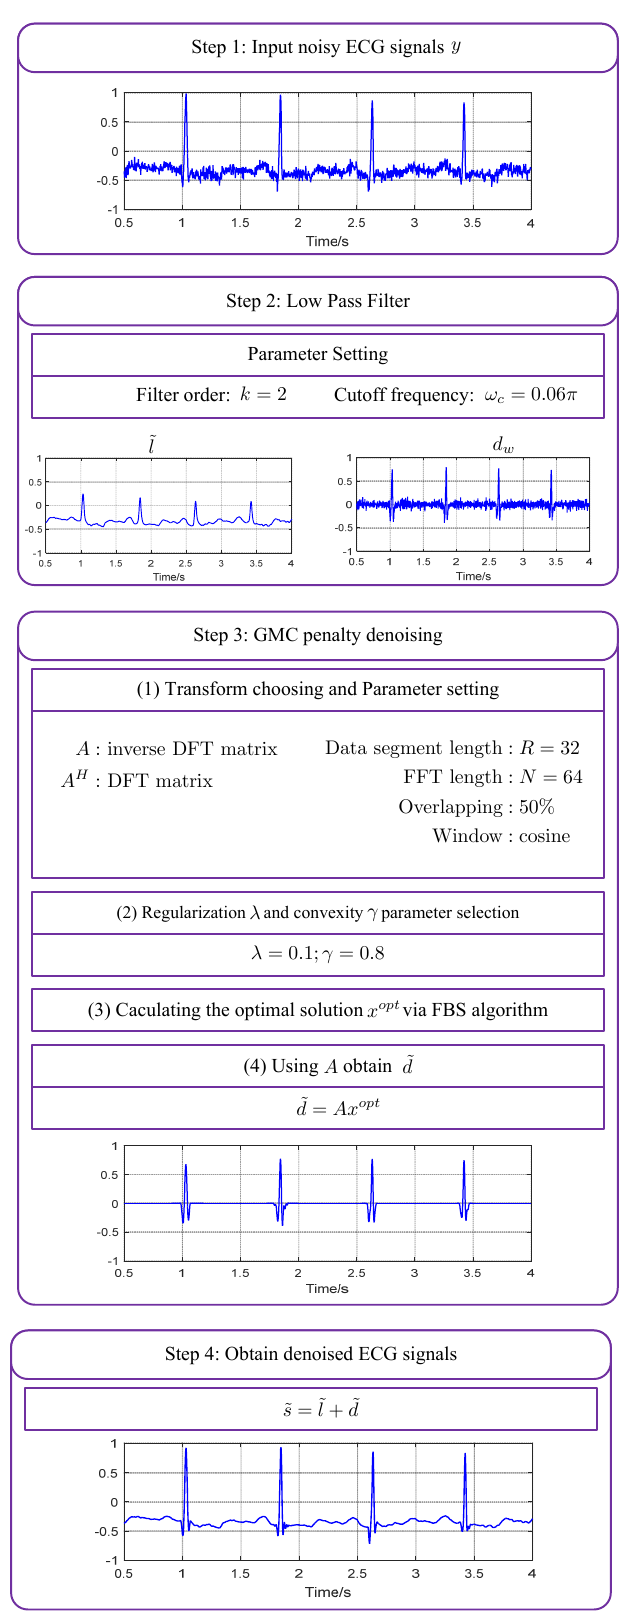
Figure 3. The detail flowchart of sparse ECG denoising with